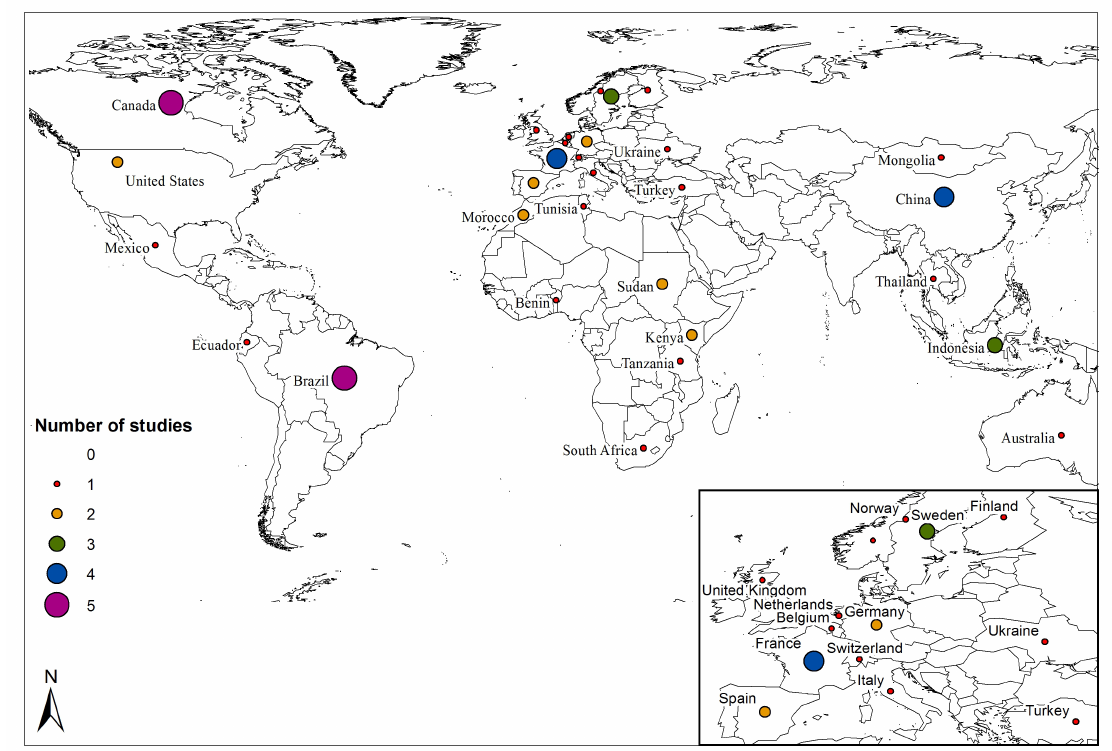
Figure 3. Locations (countries) of study sites in land use-related studies selected for analysis. Studies that covered sites located in more than one country are mapped more than once.